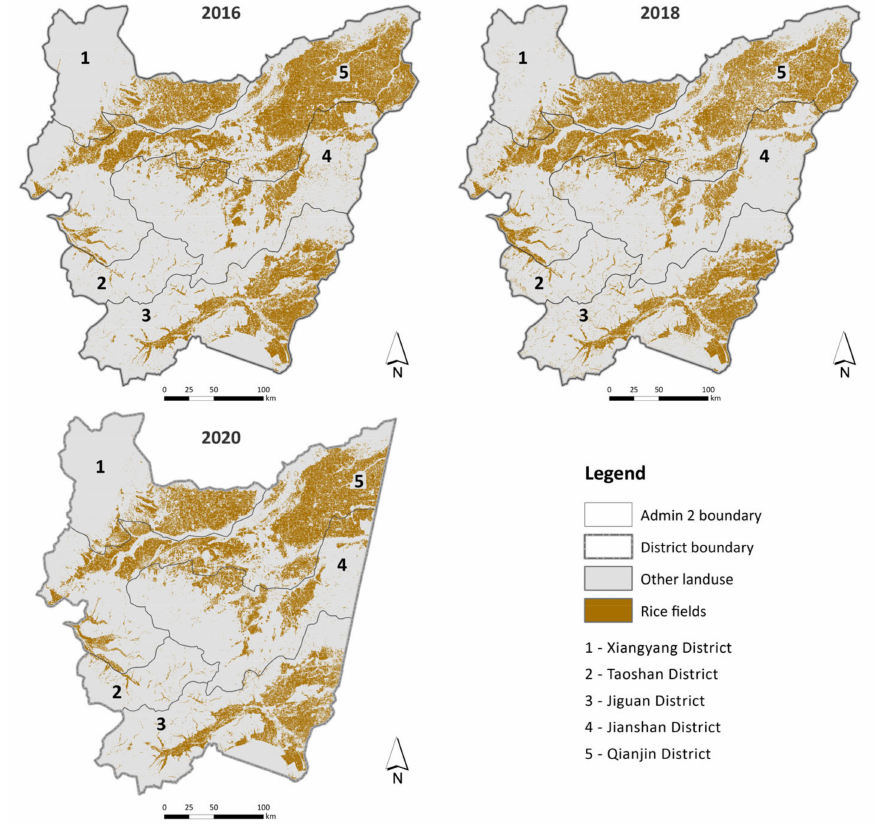
Figure 5. Paddy rice map fields of selected districts in southeastern Heilongjiang province (Xiangyang, Taoshan, Jianshan, Jiguan, and Qianjin). The 2020 boundaries were modified based on the limited Sentinel-1 radar data coverage in Jianshan, Jiguan, and Qianjin